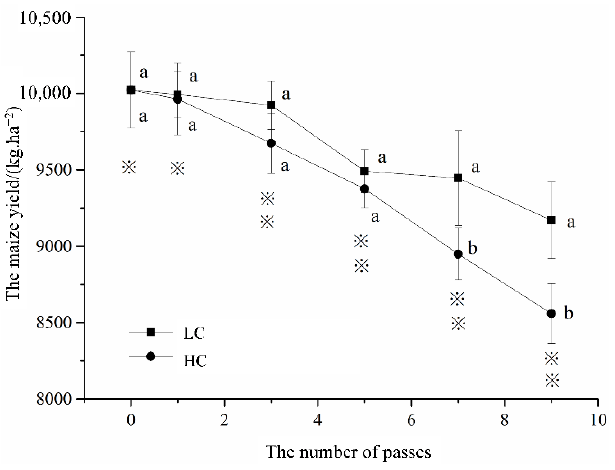
Figure 10. Effect of soil compaction on maize yield. Note: The same letters in the figure indicate that there is no significant difference in maize yield under two load compaction conditions, while the different letters indicate that there is a significant difference in maize yield caused by two treat- ments. In the figure, ※ indicates that there is no difference in yield between soil compaction treat- ment and non-compaction treatment, and two ※ indicates that maize yield is significantly reduced.